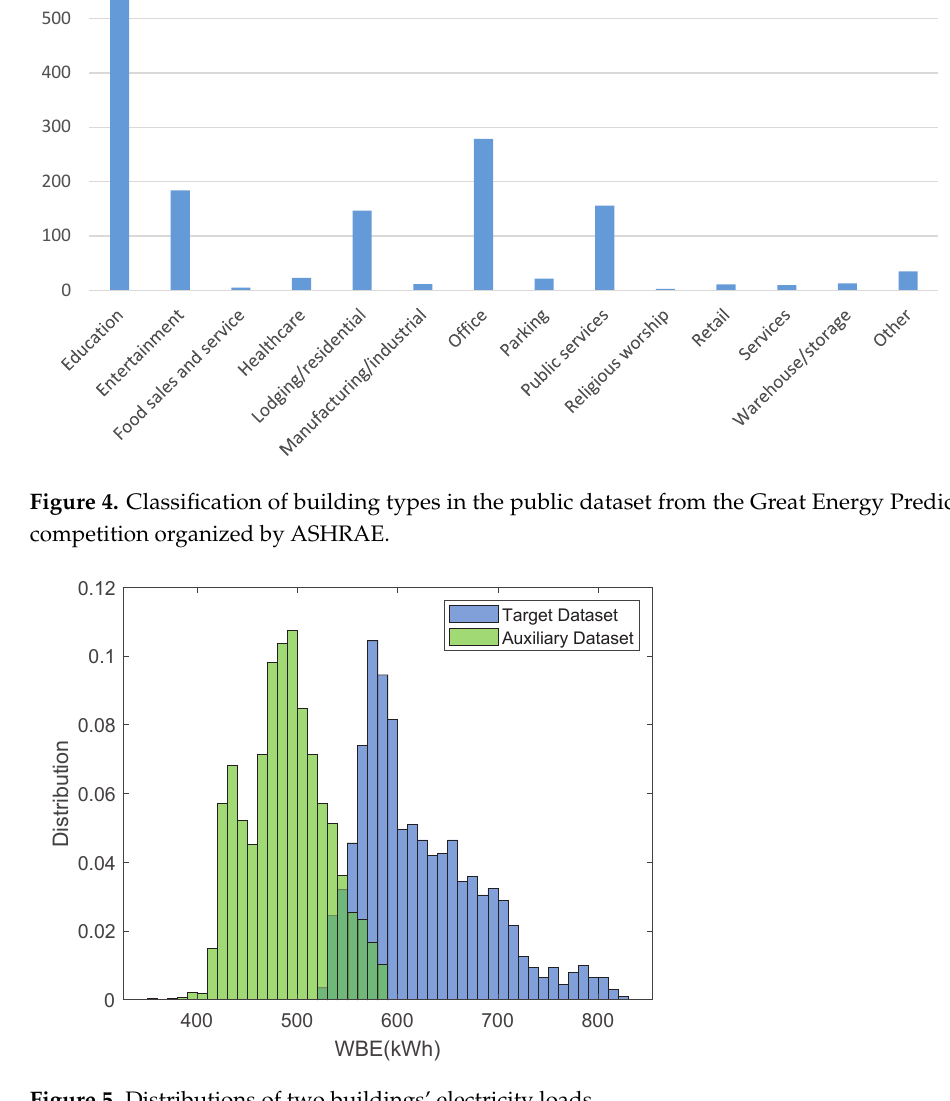
Figure 5. Distributions of two buildings’ electricity loads.